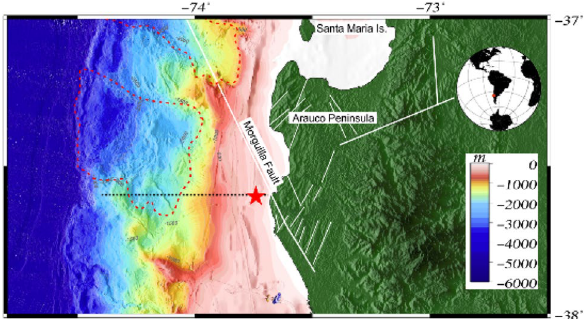
Figure 1. Location map of the studied area. The red star shows corer recovery and bathymetric surveys. The black dashed line shows the bathymetric profile used in Fig. 8, the white solid lines indicate faults and fractures described by several authors 53,92,93 and the red dashed lines show embayments related to ancient slides reported by 92